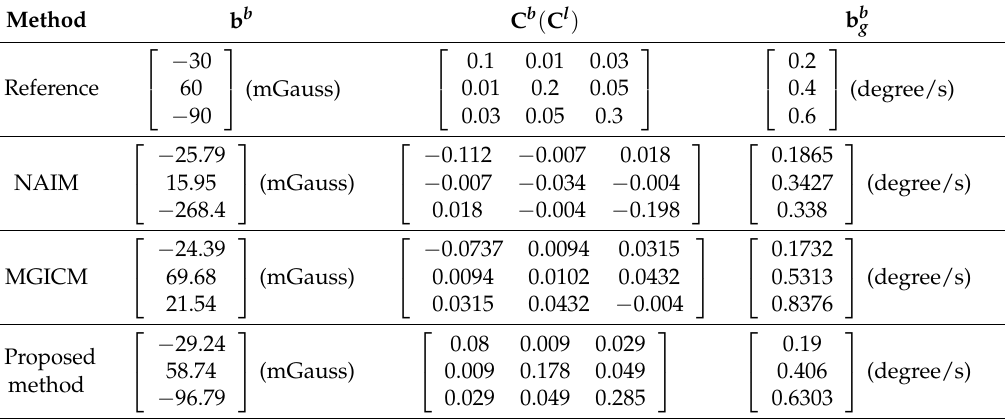
Table 3. Simulation results.